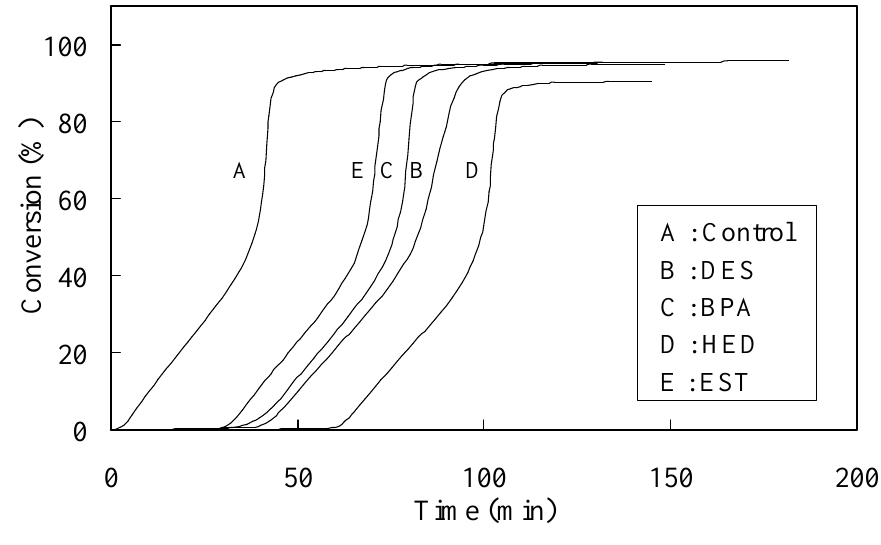
Figure 3 . Time-conversion curves for the polymerization of MMA with 1.0 mol% AIBN in the presence of 0.1 mol%